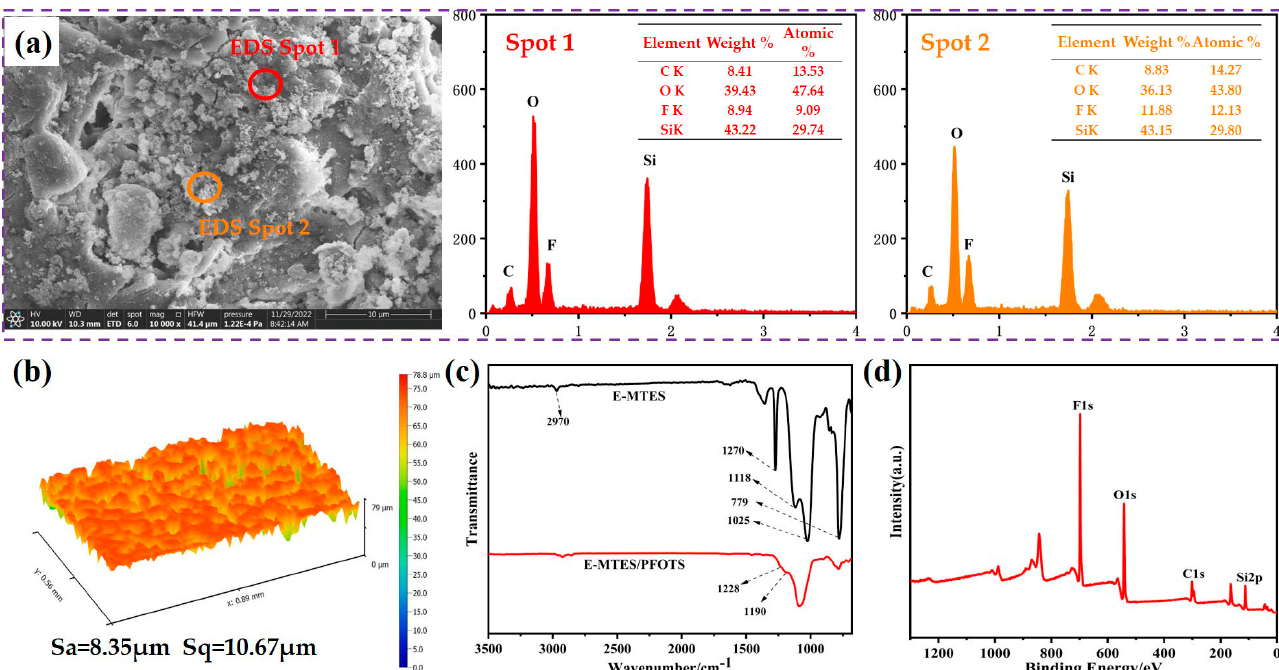
Figure 6. ( a ) FE-SEM image and EDS spectra of the superhydrophobic coating. ( b ) 3D morphology and roughness of superhydrophobic coating. ( c ) FT-IR spectrum of the E-MTES and E-MTES/PFOTS coatings, and ( d ) XPS spectrum of PFOTS coating surface (E-MTES parameters are − 1.2 V vs. Ag/AgCl for 600 s).